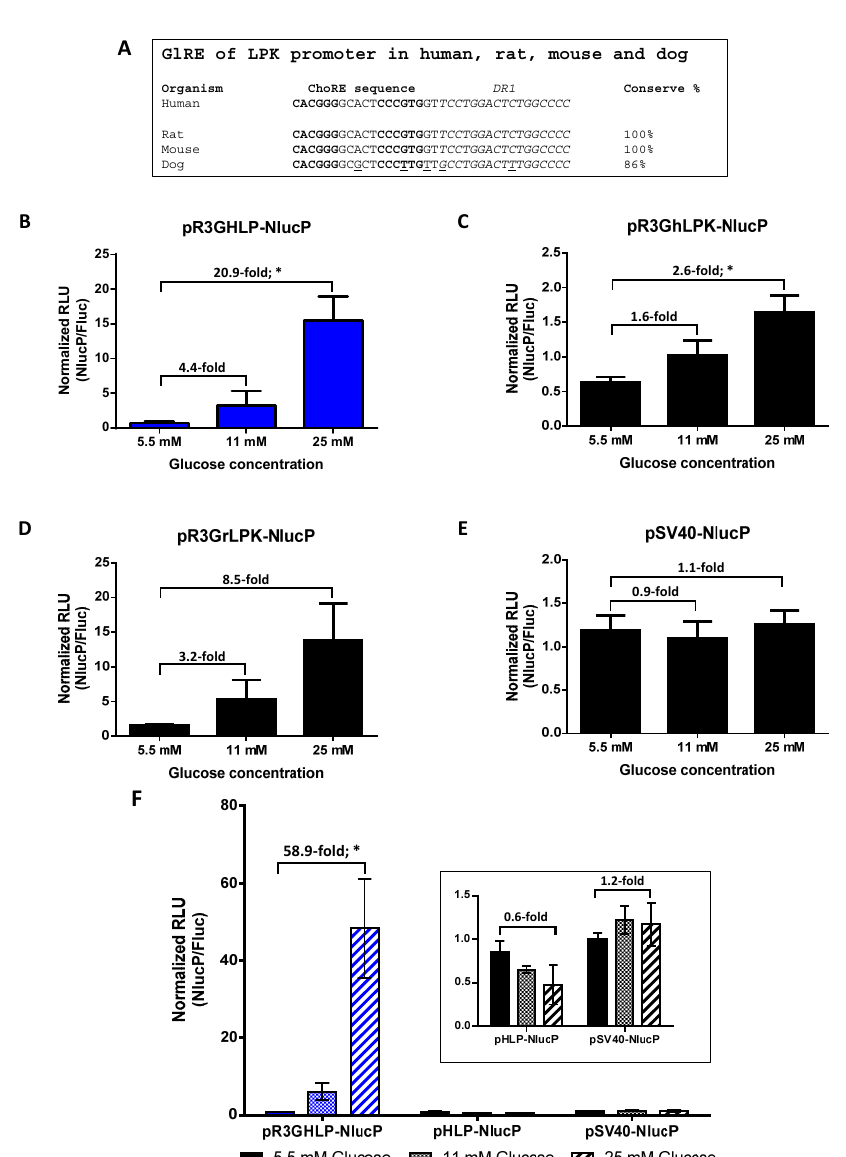
Figure 1. Effects of conserved glucose responsive elements in liver pyruvate kinase (LPK) promoter, glucose responsive elements (R3G) in converting constitutive human liver-specific promoter to glucose responsive human liver-specific promoter. ( A ) Sequence alignment of glucose responsive element (GlRE) sequences from LPK promoters between human, rat, mouse and dog. The conserved regions consist of carbohydrate response element (ChoRE) sequence and DR1 site. ( B ) Glucose responsive gene expression by R3GHLP glucose responsive human liver-specific promoter. ( C ) R3GhLPK and ( D ) R3GrLPK with human and rat LPK minimal promoters, respectively, were used as positive controls. ( E ) SV40 promoter was used as negative control. ( F ) Comparison of glucose responsiveness and gene expression level of R3GHLP glucose responsive human liver-specific promoter versus HLP constitutive human liver-specific promoter. Freshly isolated primary rat hepatocytes (rHeps) culture were co-transfected with experimental plasmid expressing PEST-destabilized nanoLuc luciferase (NlucP) reporter plasmid and pSV40-Luc2 expressing firefly luciferase (Fluc) constitutively expressed control reporter plasmid. For each sample, NlucP activity was normalized to Fluc activity from pSV40-Luc2 regulated by SV40 constitutive promoter. Glucose were added to a final concentration of 5.5 mM, 11 mM, or 25 mM. Data were presented as mean ± standard error of mean (s.e.m.) n = 3. Statistical significances were determined by Student’s unpaired t -test where * indicates p < 0.05 and considered statistically